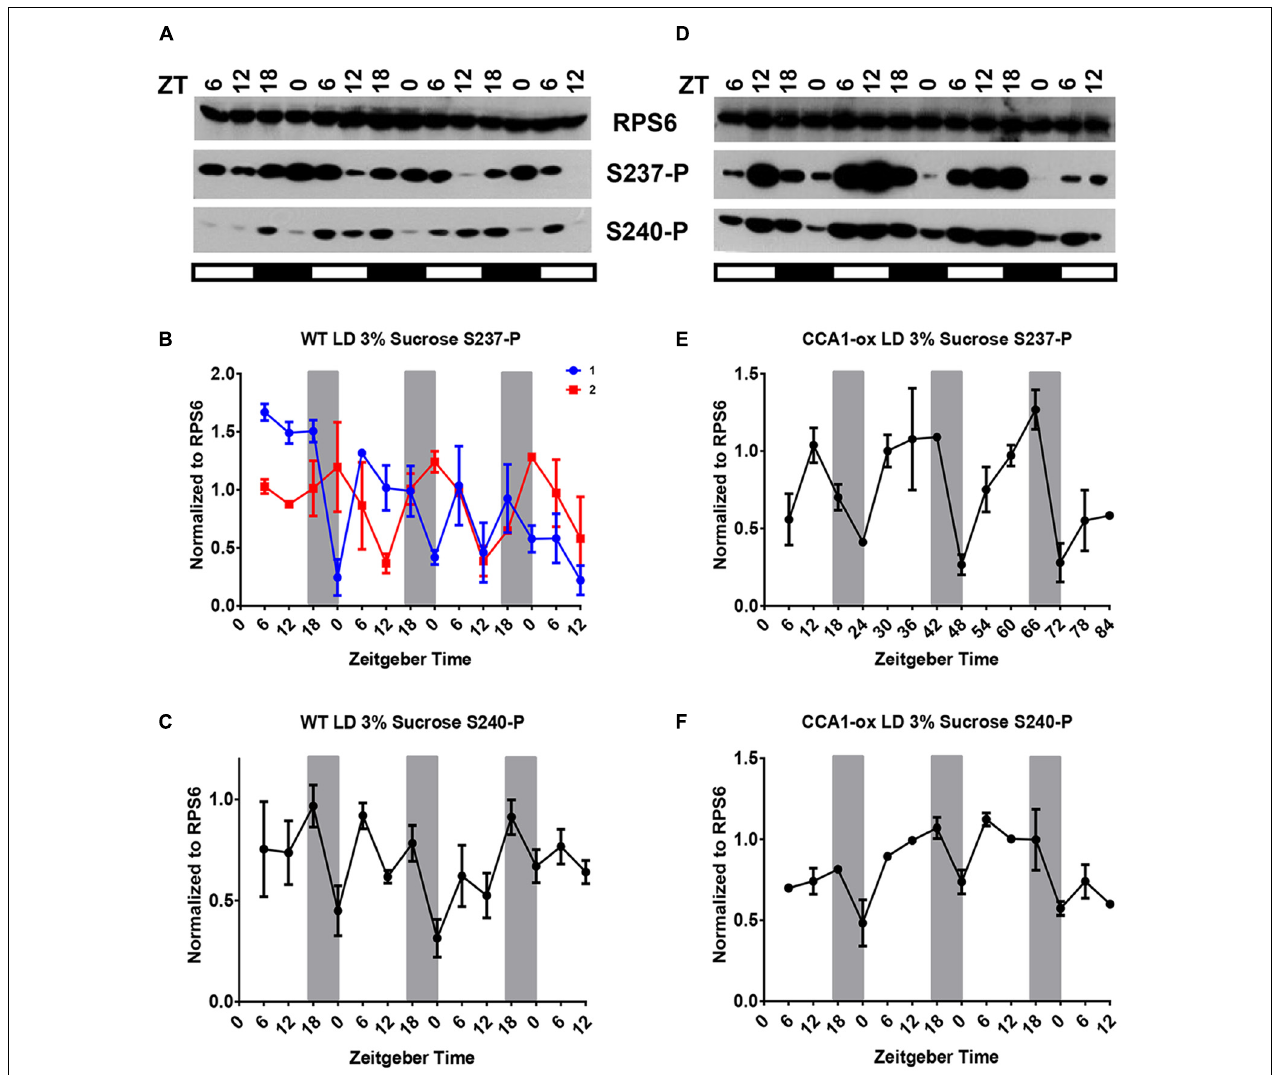
FIGURE 6 | RPS6-P at 3% sucrose under long-day conditions. (A–C) Wild-type. (D–F) CCA1-ox. Experiments were performed at least twice at different times. For details see legend to Figure 1